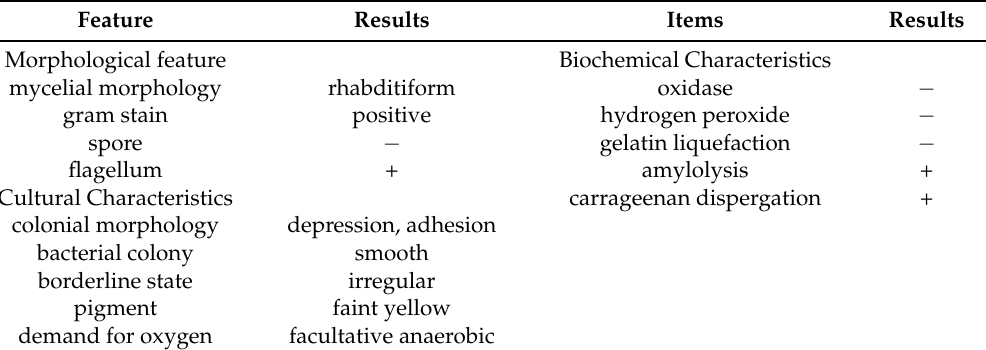
Table 1. Physiological and biochemical characteristics.